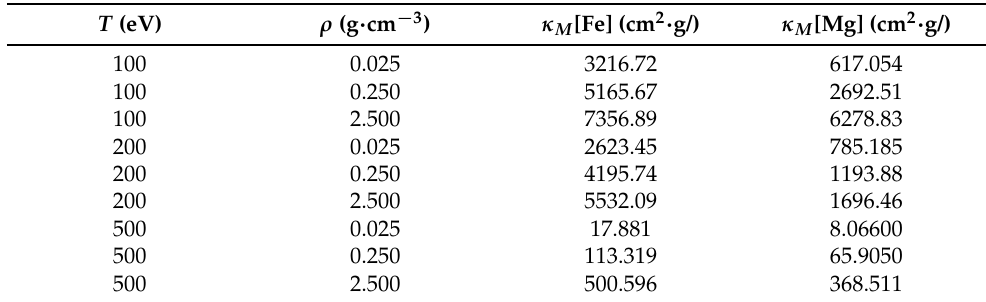
Table 6. Partial Milne mean opacities (see Equation (19)) of iron and magnesium for a mixture plasma (number fractions of Fe and Mg are both equal to 0.5) at different temperatures (100, 200, and 500 eV) and densities (0.025, 0.25, and 2.5 g cm − 3 ). These partial densities are obtained by applying the same · electronic pressure to all ions in the plasma